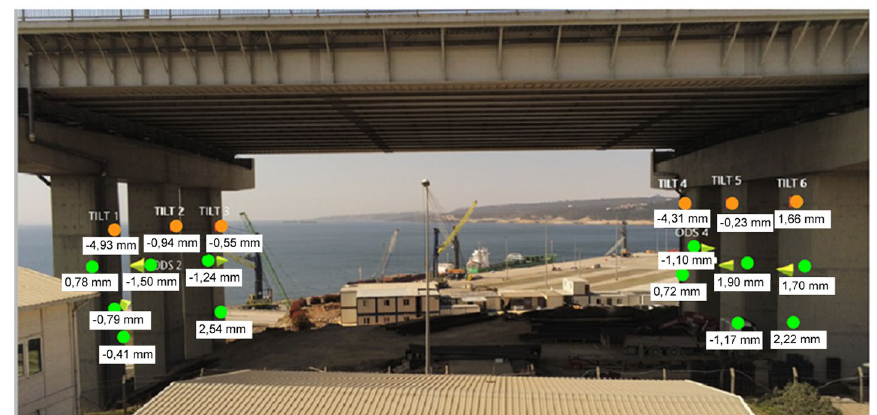
Fig. 17 Readings dated (01.06.2022) after the completion of the tunnel from tiltmeters and ODSs placed on Viaduct P-02 and P-03 legs (Orange dots show Tilt Meters, green dots show ODS points, yellow arrows show the direction of